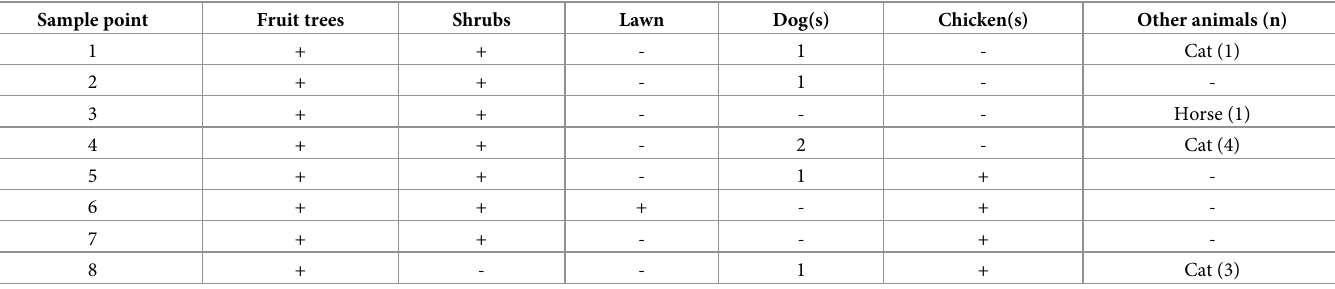
Table 1. Characterization of sampling points for sand fly fauna analysis. Sample point Fruit